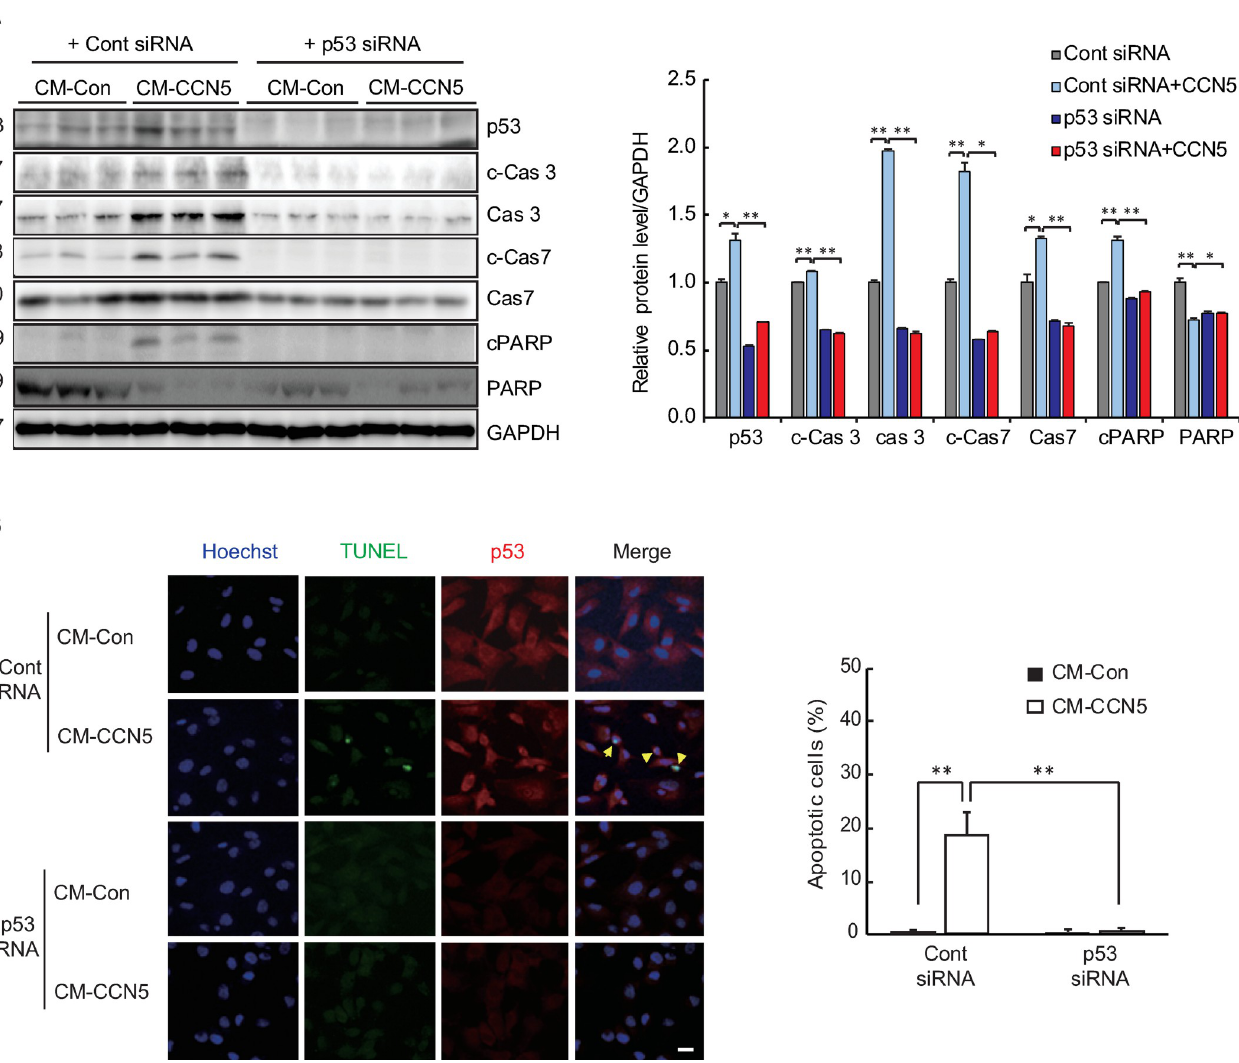
Fig 2. p53 is involved in CCN5-mediated apoptosis of MyoFBs. Freshly prepared FBs were transfected with 30 nM p53 siRNA and trans-differentiated to MyoFBs by treating them with 10 ng/mL TGF- β for 48 hours. MyoFBs were then cultured in control conditioned media (CM-Con) or CCN5-containing conditioned media (CM-CCN5) for a further 48 hours. (A) Cell lysates were then used for western blotting analysis of p53, caspase 3 (Cas3), cleaved caspase 3 (c-Cas3), caspase 7 (Cas7), cleaved caspase 7 (c-Cas7), Poly (ADP-ribose) polymerase (PARP), and cleaved PARP (cPARP). GAPDH was used as a loading control. (B) Cells were co-stained with TUNEL (green) and p53 (red). Hoechst dye was used for nuclear staining. TUNEL-positive apoptotic cells were counted and plotted. Scale bar is 50 μ m. For each group, three independent cultures were prepared and treated (n = 3). � P < 0.05, �� P < 0.01. with the SMAD7 siRNA inhibited the cleavage of caspases 3 and 7 and PARP-1 (Fig 4A). TUNEL assay also revealed that pre-incubation with the SMAD7 siRNA inhibited CCN5-me- diated apoptosis of MyoFBs, whereas the control siRNA exhibited no effects (Fig 4B). These data suggest that SMAD7 plays a critical role in CCN5-mediated MyoFB apoptosis. CCN5 regulates the transcription of SMAD7 CCN5 acts as a transcriptional co-repressor and regulates the expression of TGF β receptor II [16]. We hypothesized that CCN5 is involved in the transcriptional regulation of other genes, including SMAD7 . Quantification of western blotting results showed that after incubating the